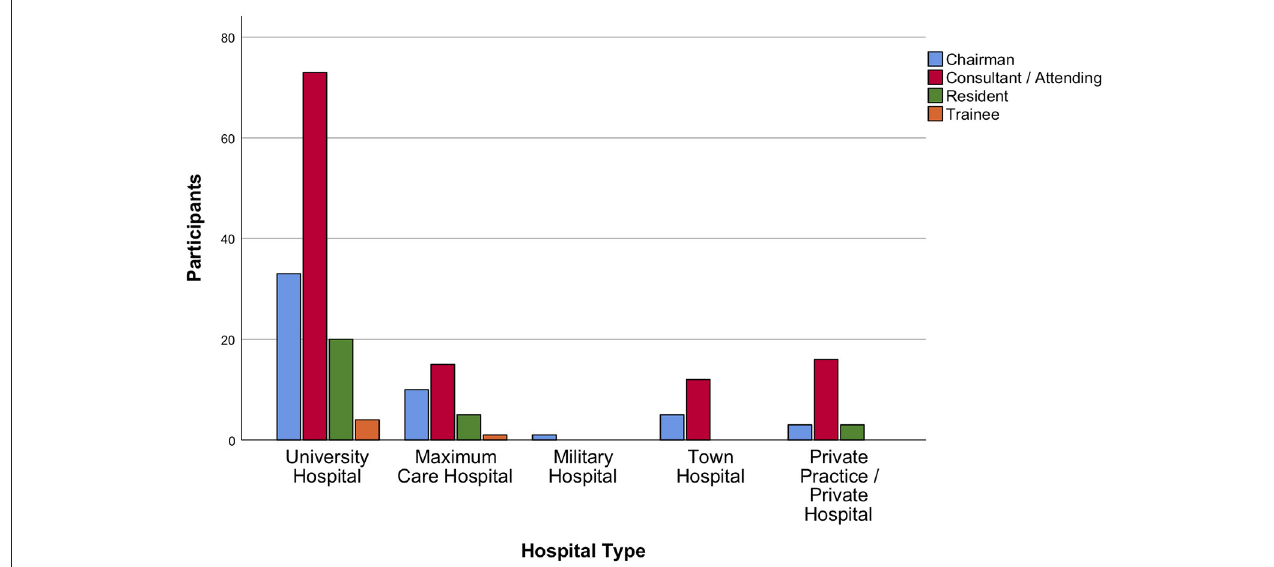
FIGURE 3 | Outpatient elective services during the acute phase of the crisis. The majority of participants confirmed termination or reduction of elective outpatient services to a minimum in their institution at some timepoint in March 2020.